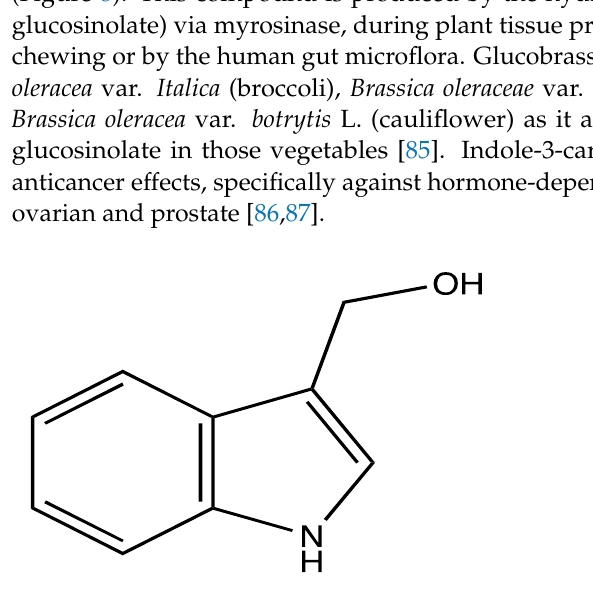
Figure 8. Structure of indole-3-carbinol isolated from different Brassica species.